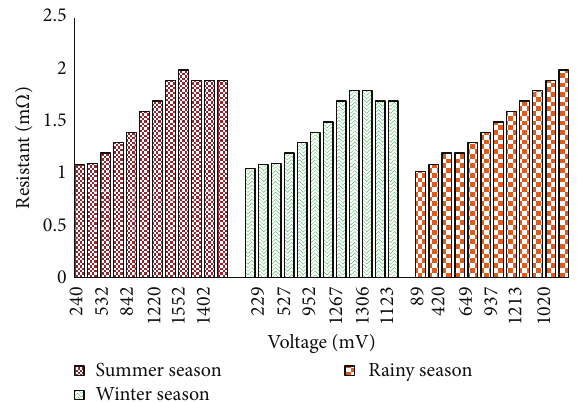
Figure 13: Comparison of voltage versus resistance in the duration of 2.00–4.00 pm in summer, winter, and rainy season.